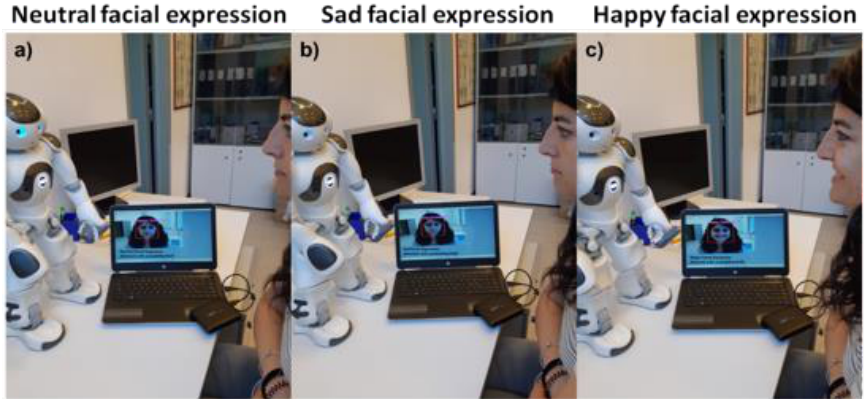
Figure 12. Pictures captured during the NAO’s interaction with a representative subject. The facial expressions detected by the NAO robot through the CNN-based FER model for ( a ) neutral, ( b ) sad, and ( c ) happy facial expressions are also displayed in the images.